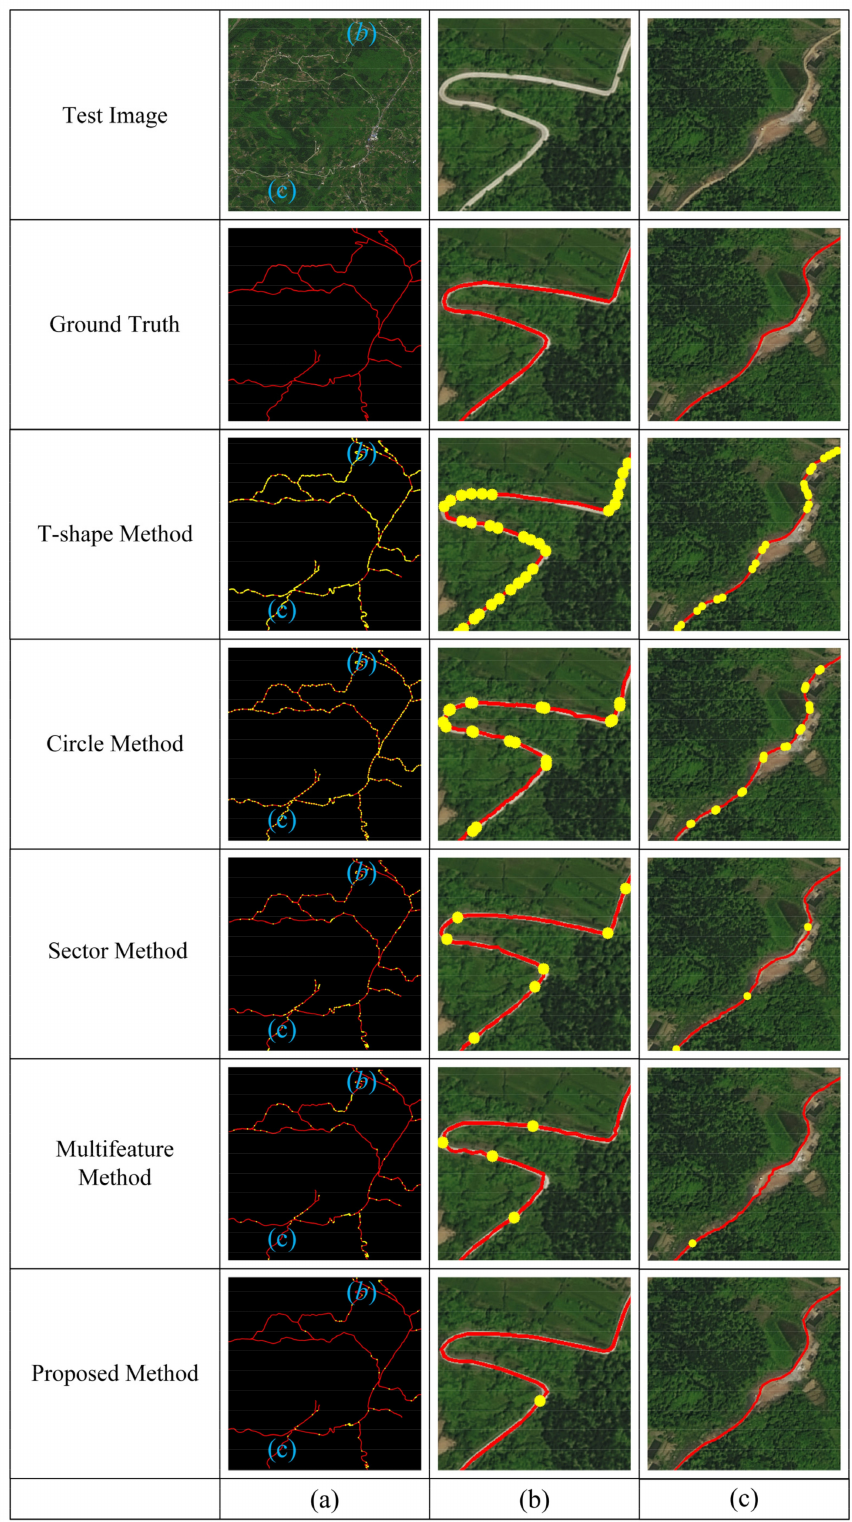
Figure 7. Road extraction results of the five methods analysed in Experiment 1. ( a ) Global